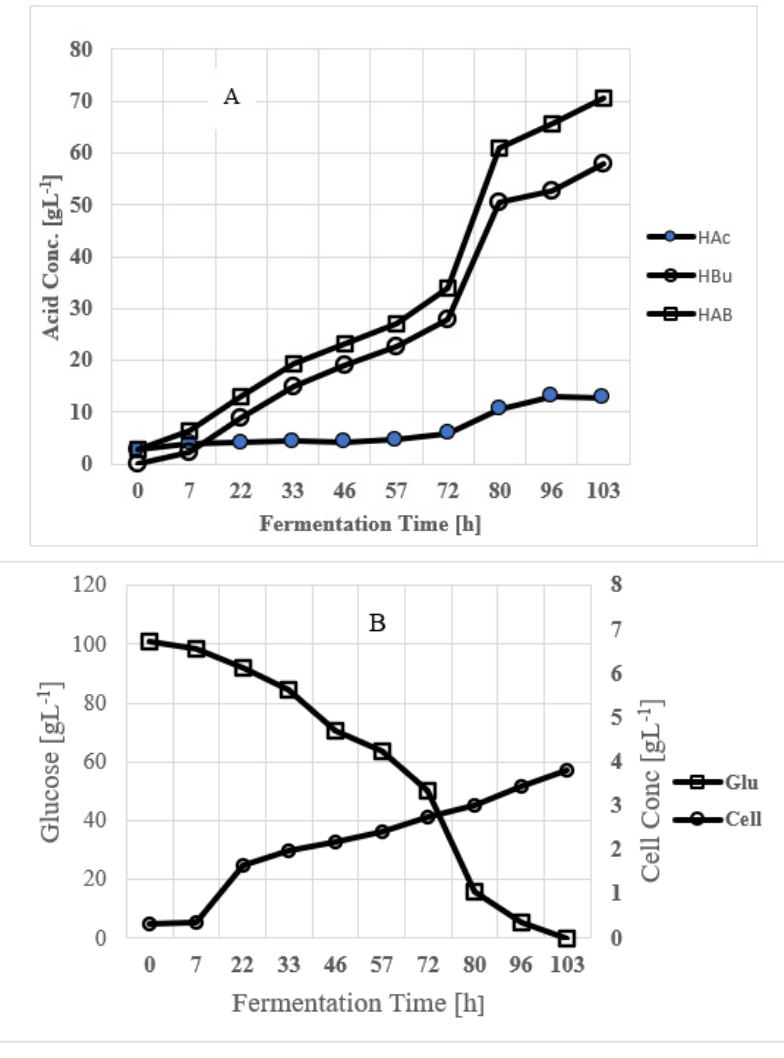
Figure 5. Fermentation time profile. ( A ) Acid concentrations. ( B ) Glucose and cell